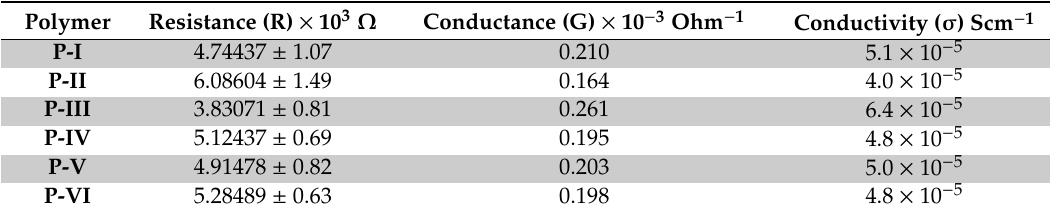
Table 3. Calculated resistance, conductance, and conductivity from the current vs voltage (I-V) curves of the polyazomethines